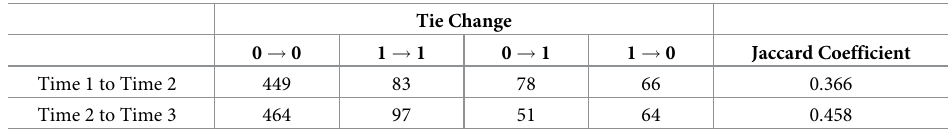
Table 1. Network